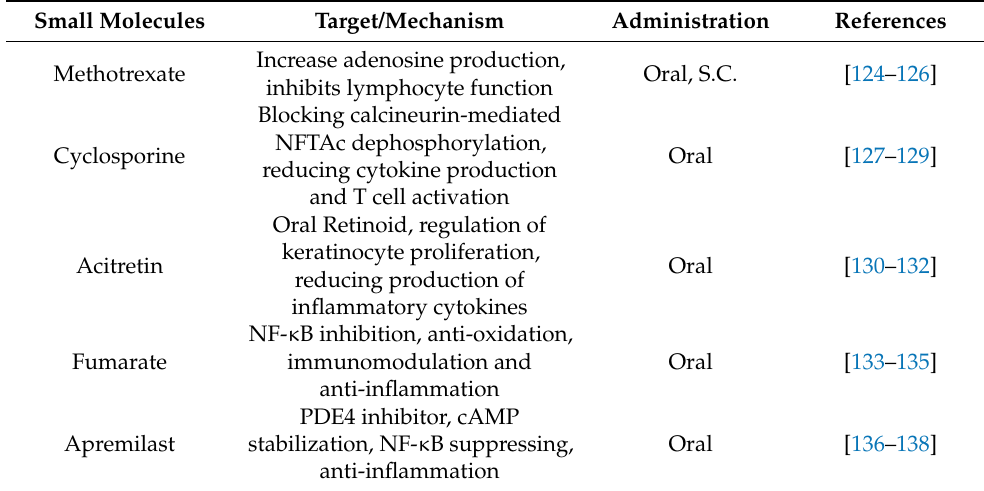
Table 1. Drugs and biologics used for treatment of